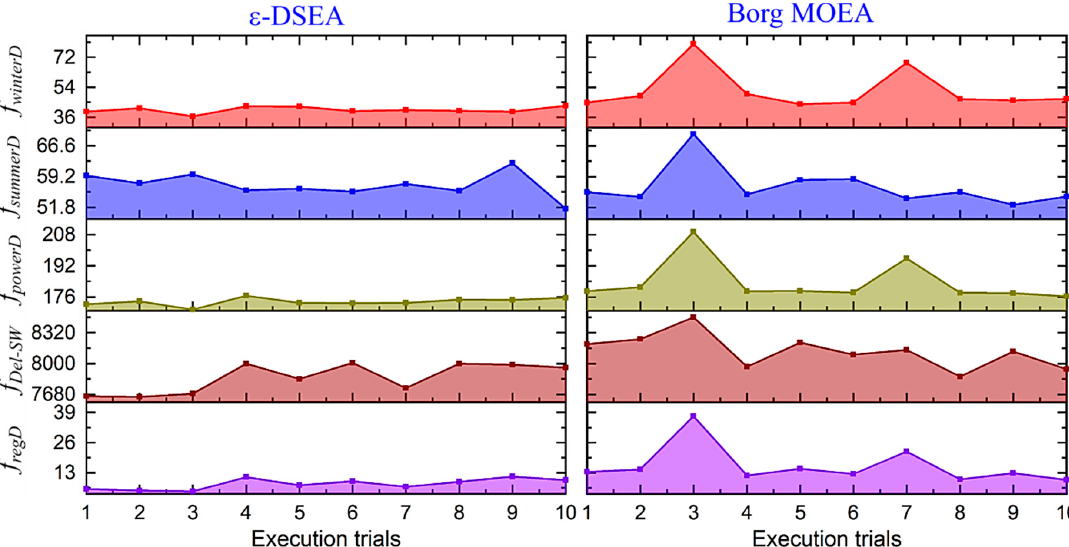
Figure 5. Five objectives’ median optimum solutions of 10 runs of both algorithms.